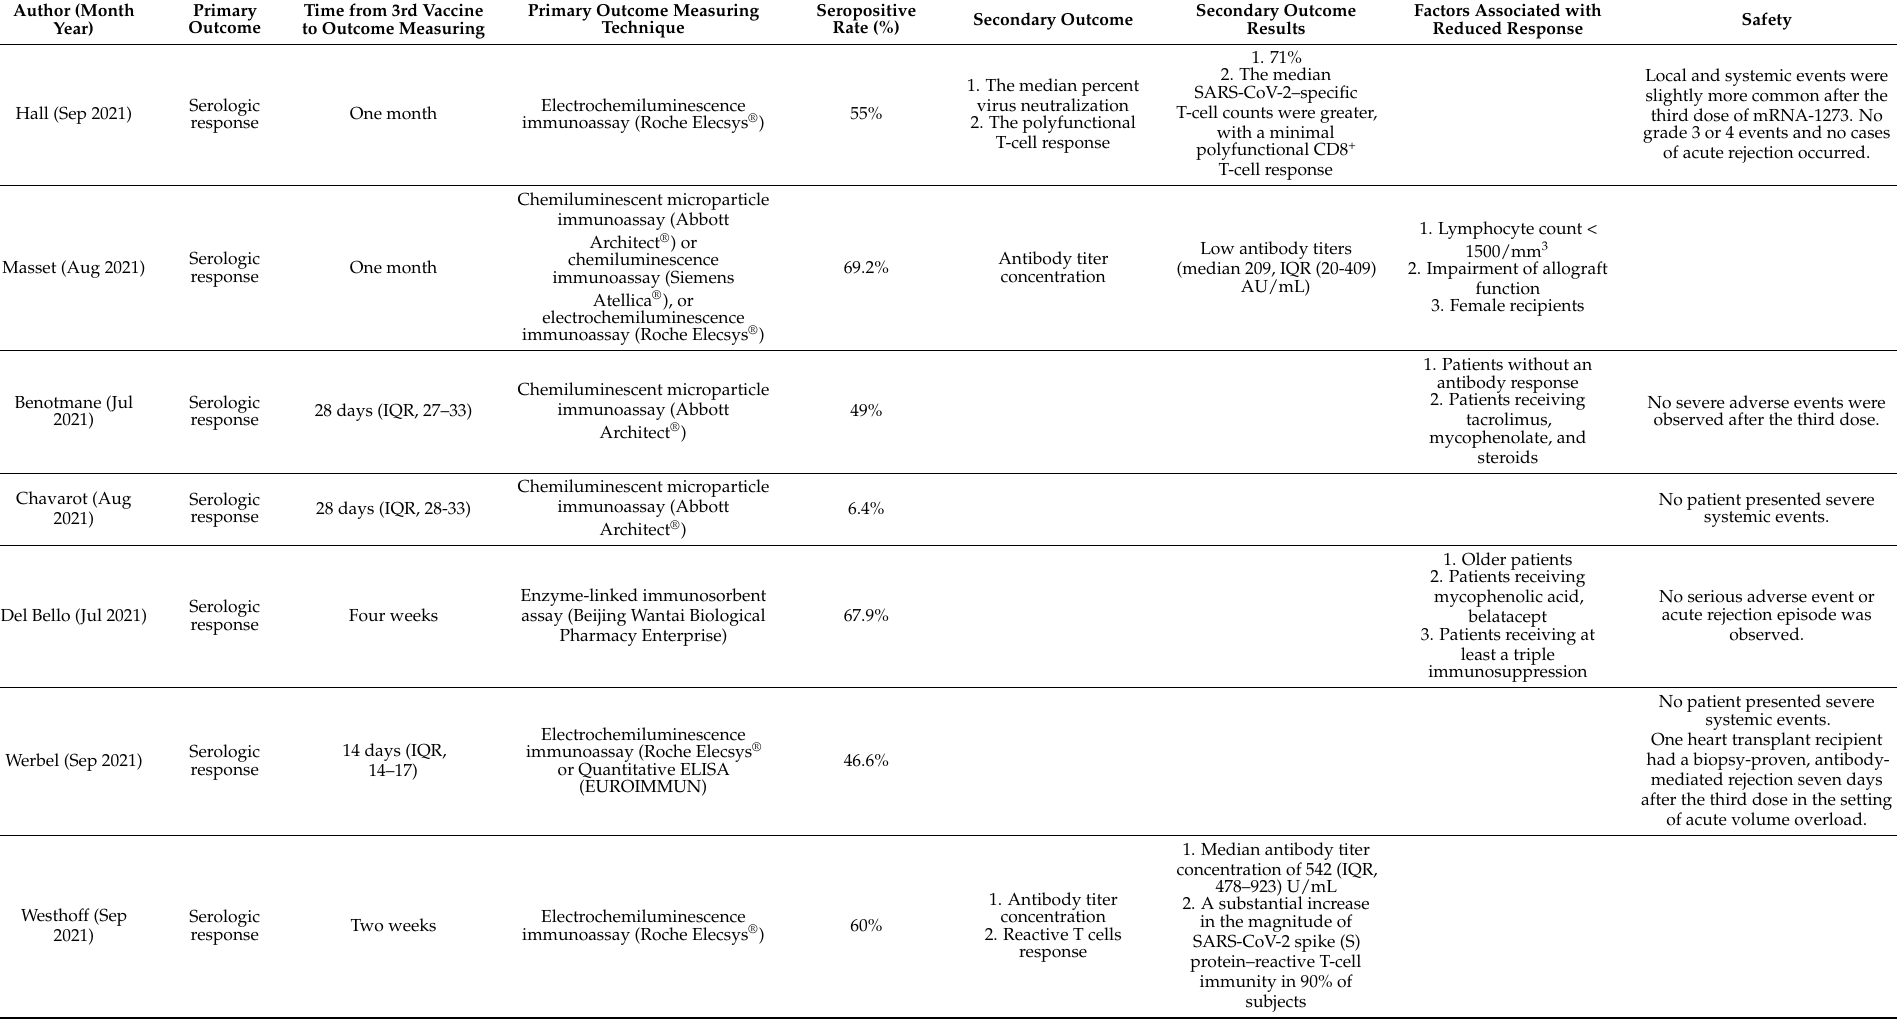
Table 2. Efficacy and safety of the third dose of COVID-19 vaccine among solid organ transplant